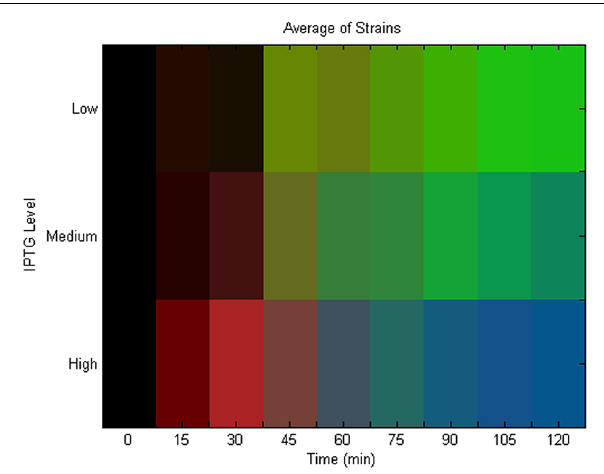
FIGURE 3 |Average localization pattern versus time and induction rate. Population and strain averaged localization pattern versus time at different induction levels.The RGB color represents the mix of patterns at each time point from diffuse (red), unipolar (green) to bipolar (blue). For each strain, an induction level was found that lead to unipolar patterning at late times (“Low”; see Figure S4) and also bipolar (“High”; see Figure S5). The IPTG concentration in between the “Low” and “High” concentration for each strain was selected for the midpoint expression level (“Medium”). The average localization pattern over all strains was then calculated for each of these induction levels.The population average for diffuse (red), unipolar (green) and bipolar (blue) is then plotted as an RGB level at each time point to make the heat map , and where black represents time points that had no